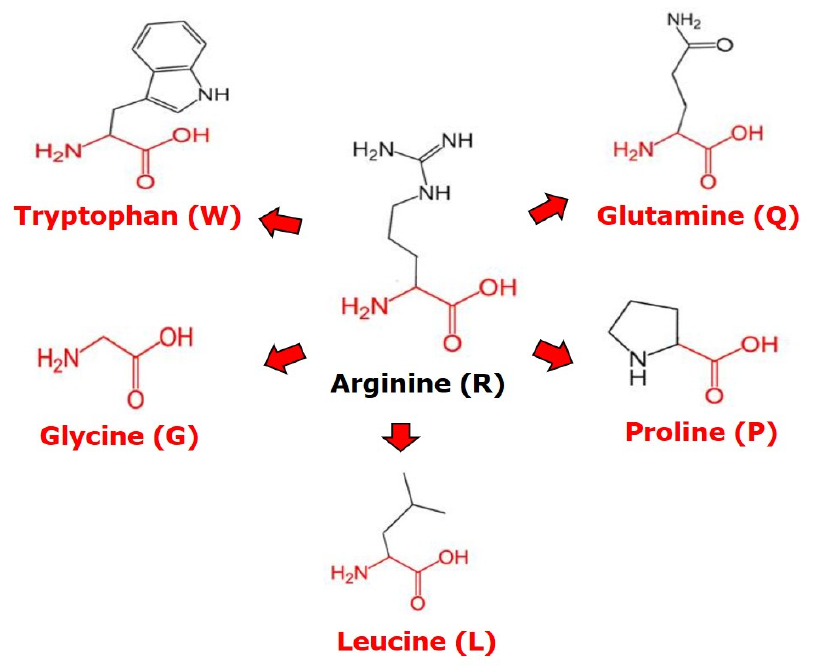
Figure 9. Structural relativity of different amino acid substitutions in p53 Arg248.